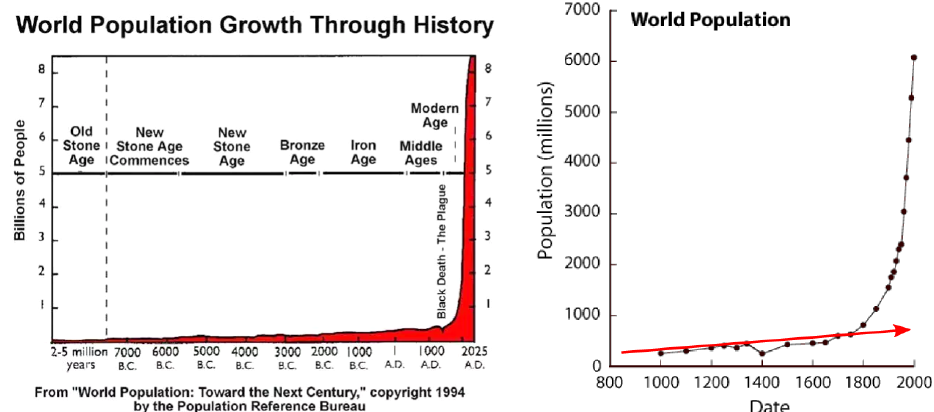
Fig. 5. – Left: world population growth through history. Right: zoomed view of the global population over the last millennium